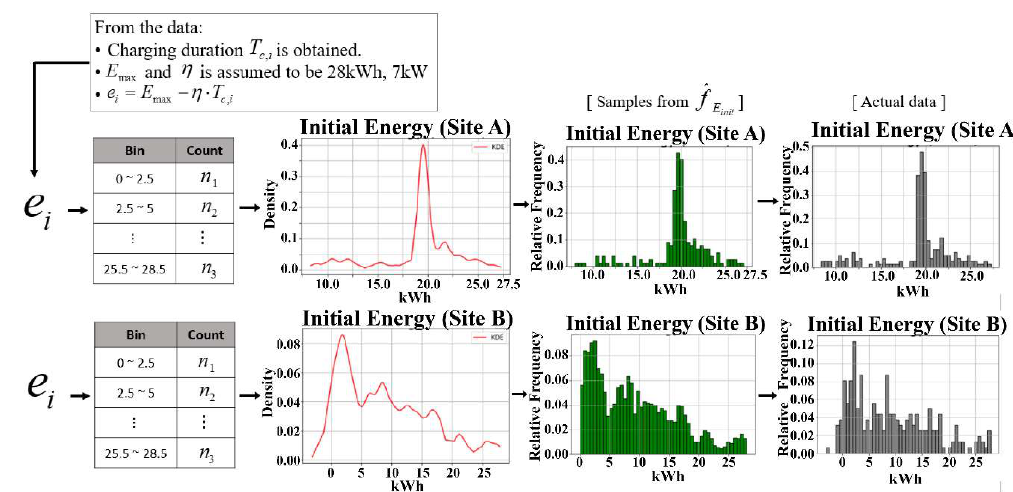
Figure 5. Results of KDE for probability distributions of an initial energy at arrival of an EV for Sites A and B.